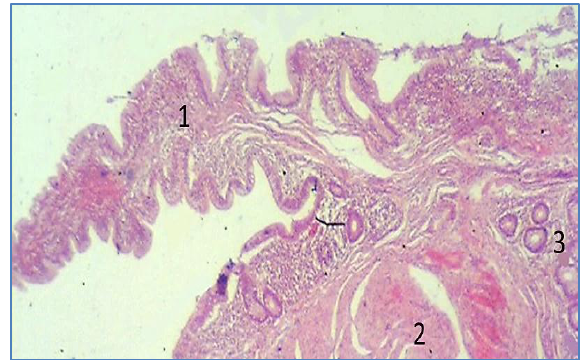
Figure, 5: Wall of the urodeum (hen turkey) shows: villi (1), tunica muscularis (smooth muscle fibers) (2) and epithelial tubular glands (3), (H and E) satin. 40x.